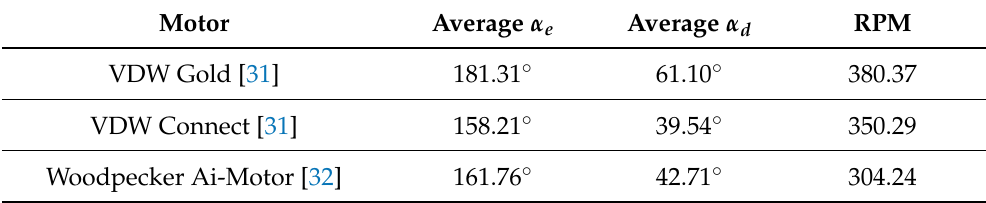
Table 1. Computed movement parameters for the considered reciprocating